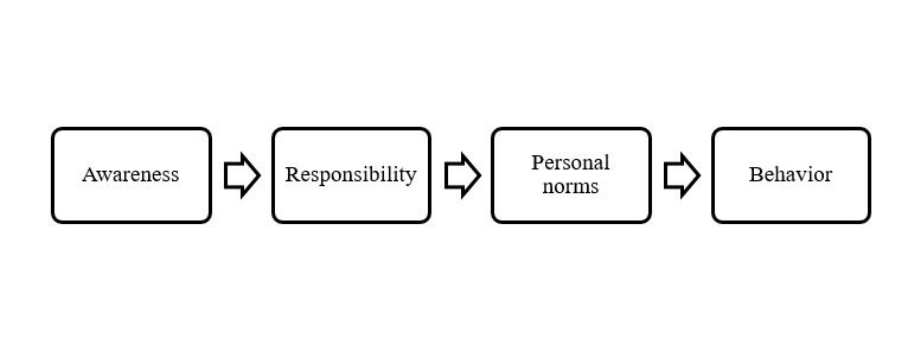
Figure 2: Norm Activation Model (De Groot & Steg, 2009; Schwartz, 1977)